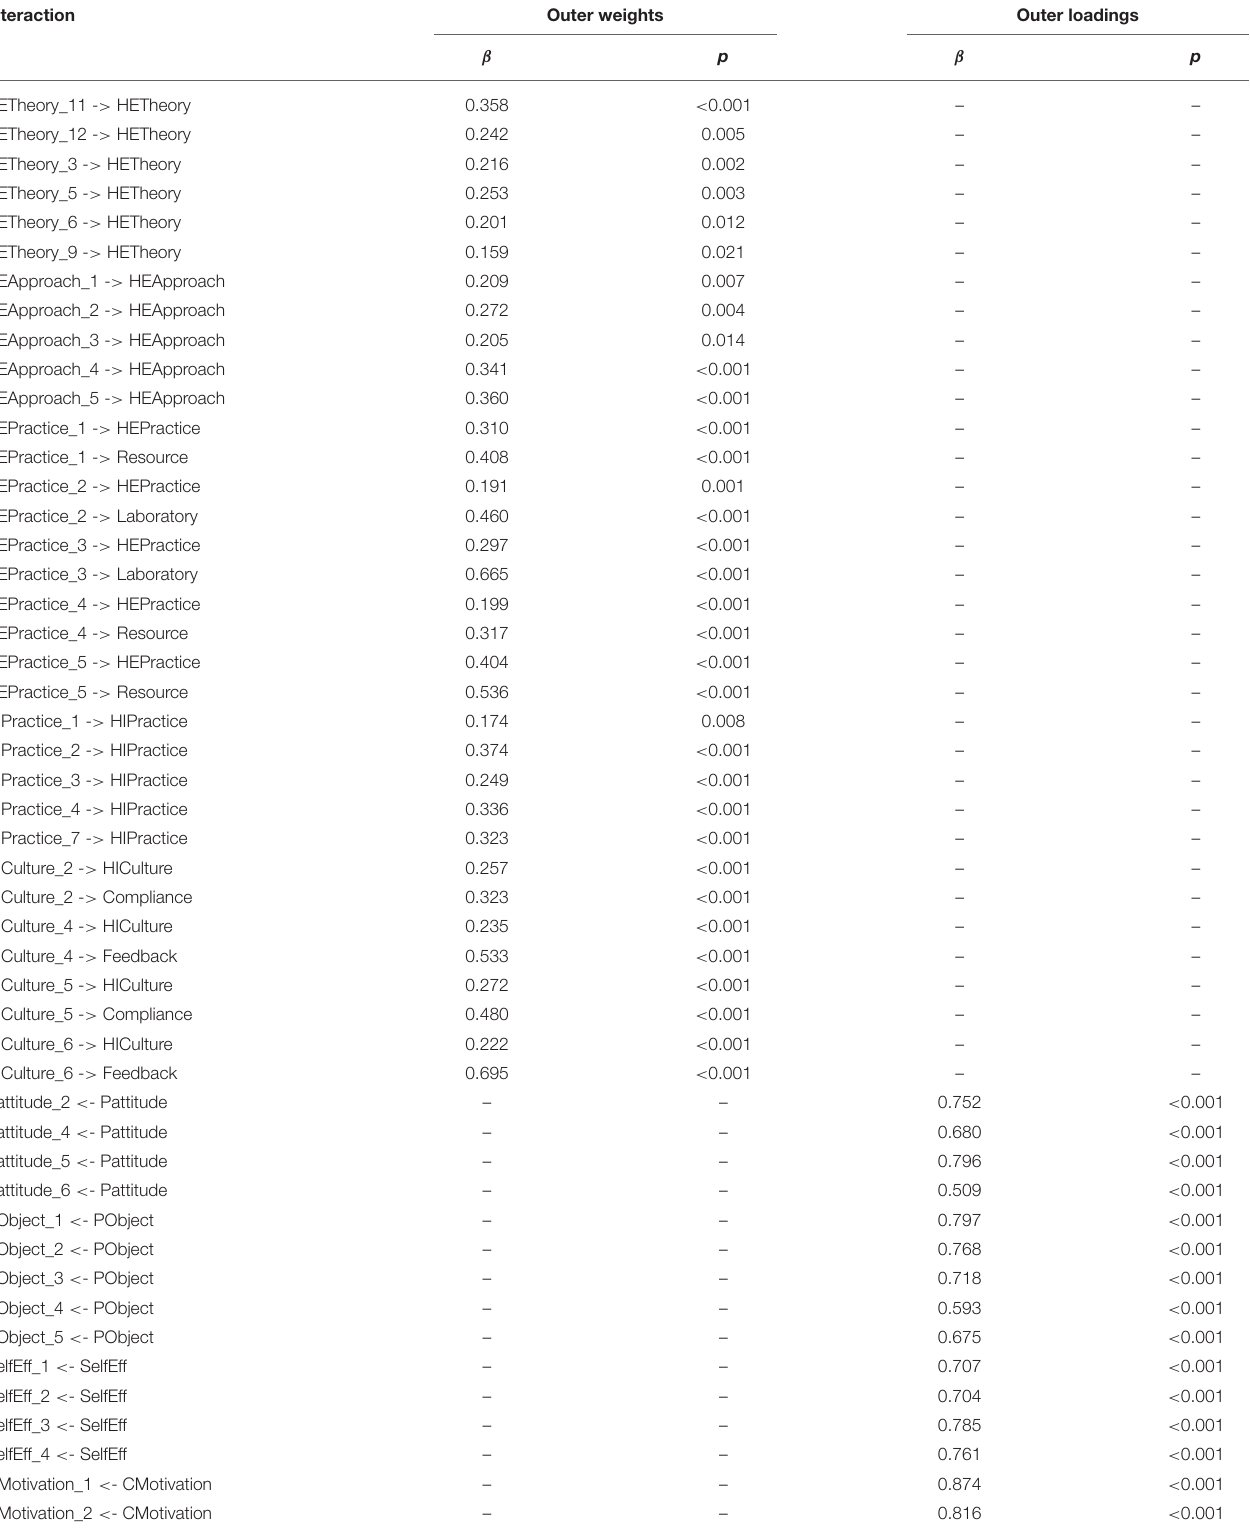
TABLE 3 | Weights and